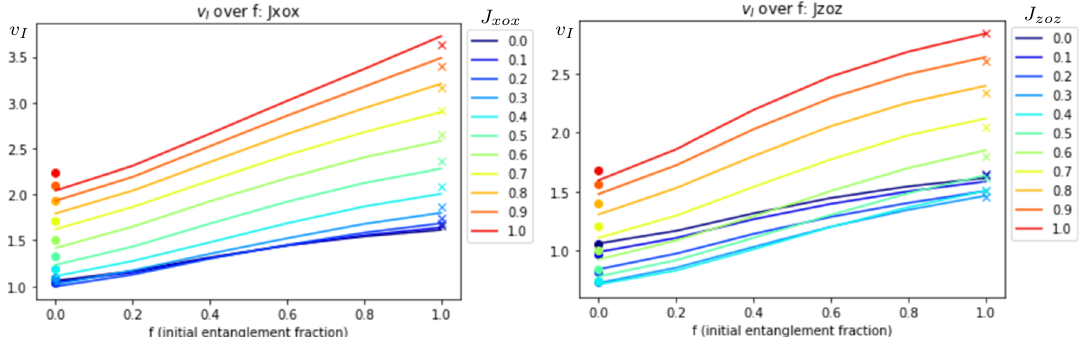
Figure 3 . Left: information velocity as a function of initial entanglement fraction f in L = 26 systems with different values of J xox nonlocal coupling (all other nonlocal couplings set to zero). Right: information velocity as a function of initial entanglement fraction f in L = 26 systems with different values of J zoz (all other nonlocal couplings set to zero). In both panels, the x ’s along the f = 1 line correspond to independent computations of v B , and the o ’s along f = 0 correspond to independent v E computations. See discussion in the main